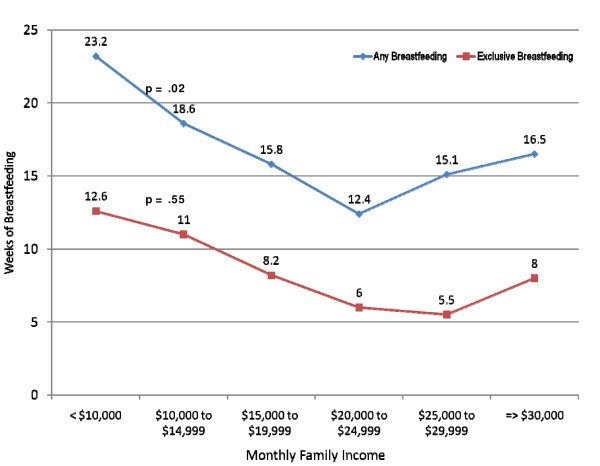
Weeks of any and exclusive breastfeeding by level of family income. Values are in Hong Kong Dollars (1 USD = 7.78 HKD). Participants lost-to-follow-up (n = 33) and those with missing income data (n = 35) were excluded. The sample size for this analysis was 1249.